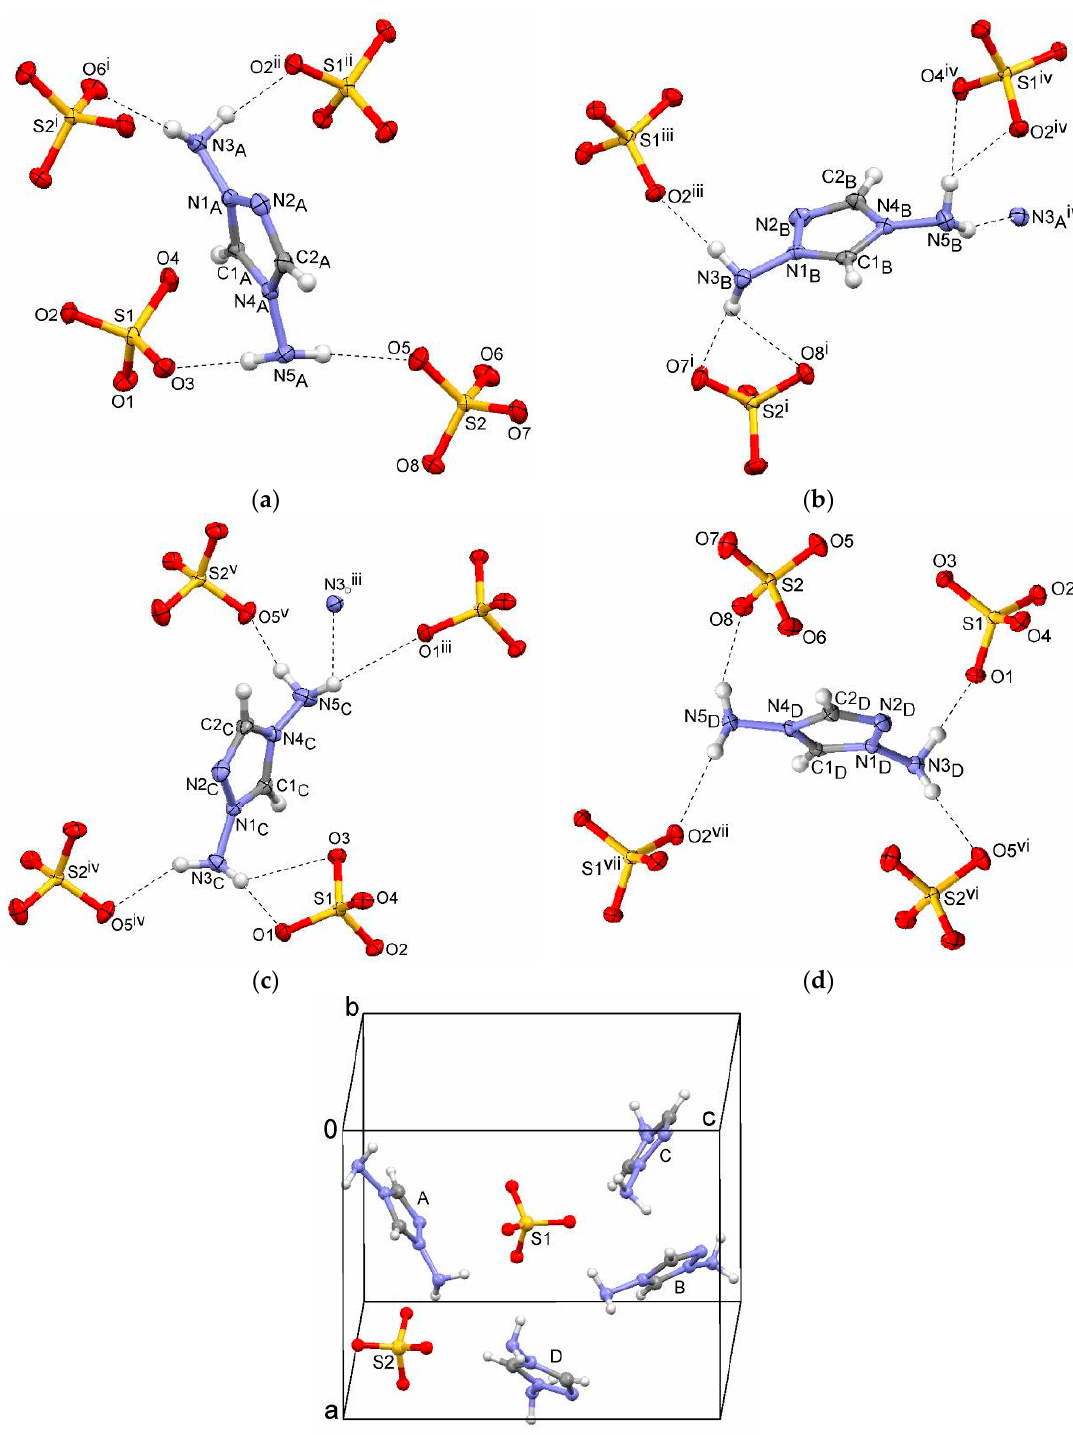
Figure 2. Bis(1,4-diamino-1,2,4-triazolium) sulfate ( 1 ). ( a – d ) The four independent cations as hydrogen-bond donors. Symmetry codes: (i) 1+ x , y , z ; (ii) x , – y , ½ + z ; (iii) x , 1 + y , z ; (iv) x , – y , –1/2 + z ; (v) x , 1 – y , –1/2 + z ; (vi) x , –1 + y , z ; (vii) –1 + x , y , z ; ( e ) Asymmetric unit.